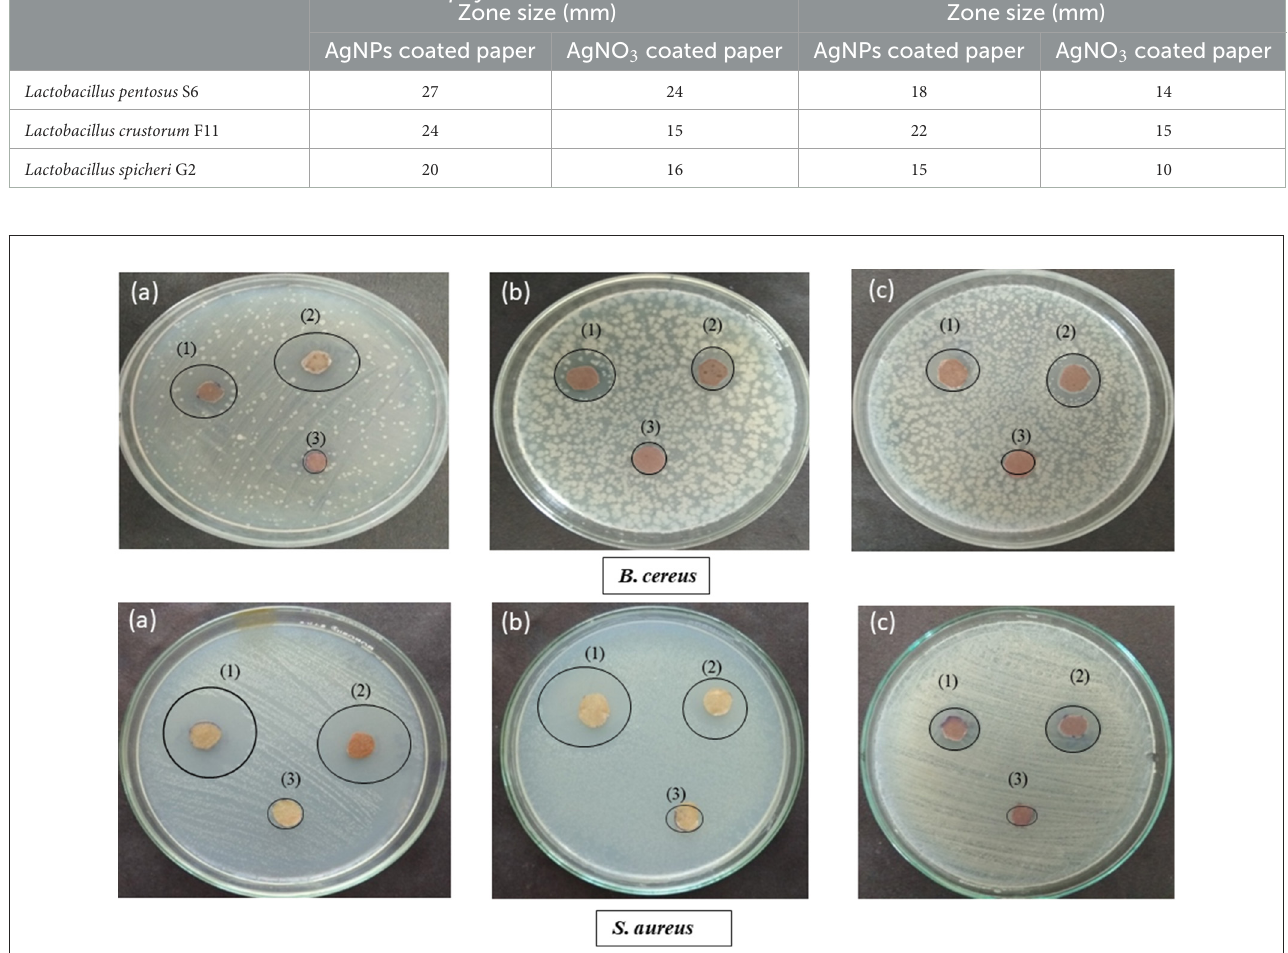
FIGURE6 Antibacterial potential of (a) F11 Ba AgNP s (b) G2 Ba AgNP s (c) S6 Ba AgNP s , where (1) represents bacteriocin AgNP s coated paper, (2) AgNO 3 coated paper and (3) uncoated paper against two different pathogens i.e., Bacillus cereus and Staphylococcus aureus .